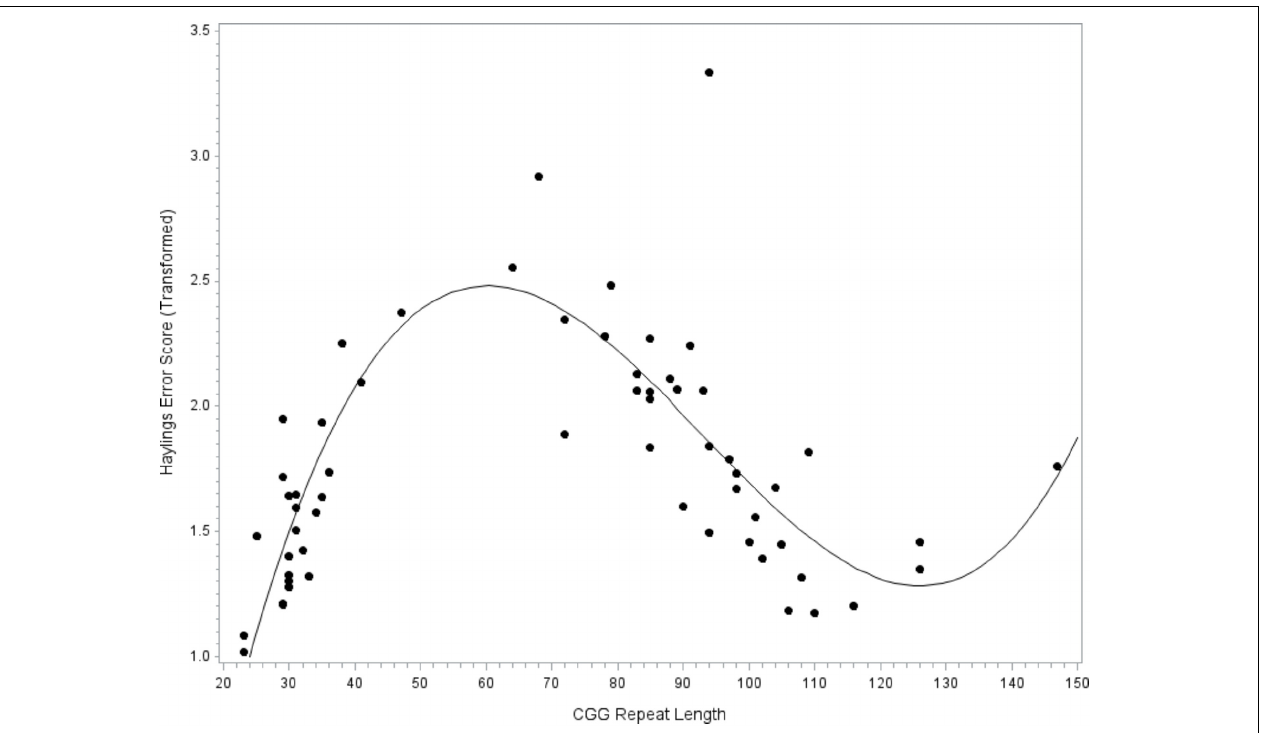
FIGURE 3 | Relationship between verbal inhibition and CGG repeat length. Cubic association between CGG repeat length and inhibition skill. Model-predicted values are shown, controlling for age, education level, IQ, and allele-1 CGG size. A higher Hayling error score reflects poorer verbal inhibition